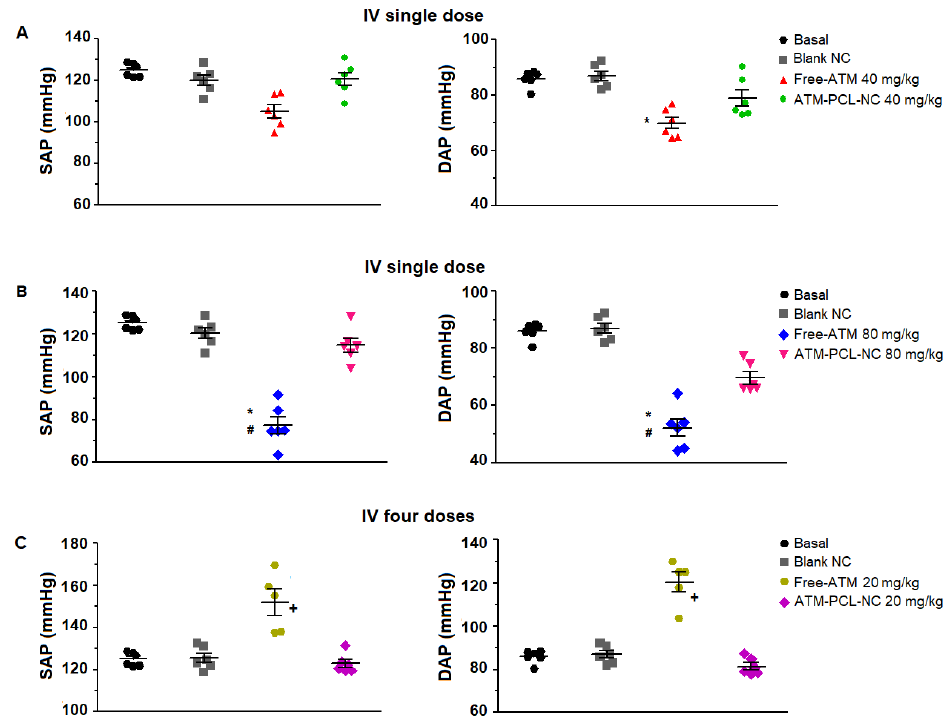
Figure 9. Maximal variation of systolic (SAP) and diastolic (DAP) pressure (mmHg) after IV administration of blank-NC, free-ATM, and ATM-PCL-NC, a single dose of 40 ( A ) and 80 mg/kg ( B ), and four doses (one every 12 h) of 20 mg/kg ( C ). * p < 0.05 compared to blank-NC and # p < 0.05 compared to ATM-PCL-NC administration, + p < 0.05 compared to basal, blank-NC, and ATM-PCL-NC. ANOVA followed by Tukey post-test.